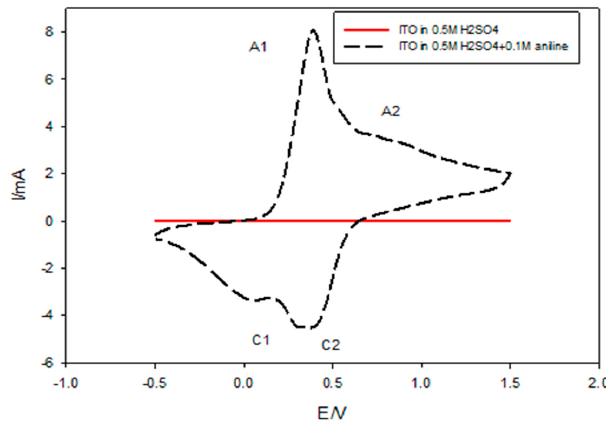
Figure 5. Cyclic voltammogram of PANI from an acidic solution of 0.5 M H 2 SO 4 containing 0.1 M aniline on an indium-doped tin oxide (ITO) electrode for 10 cycles of